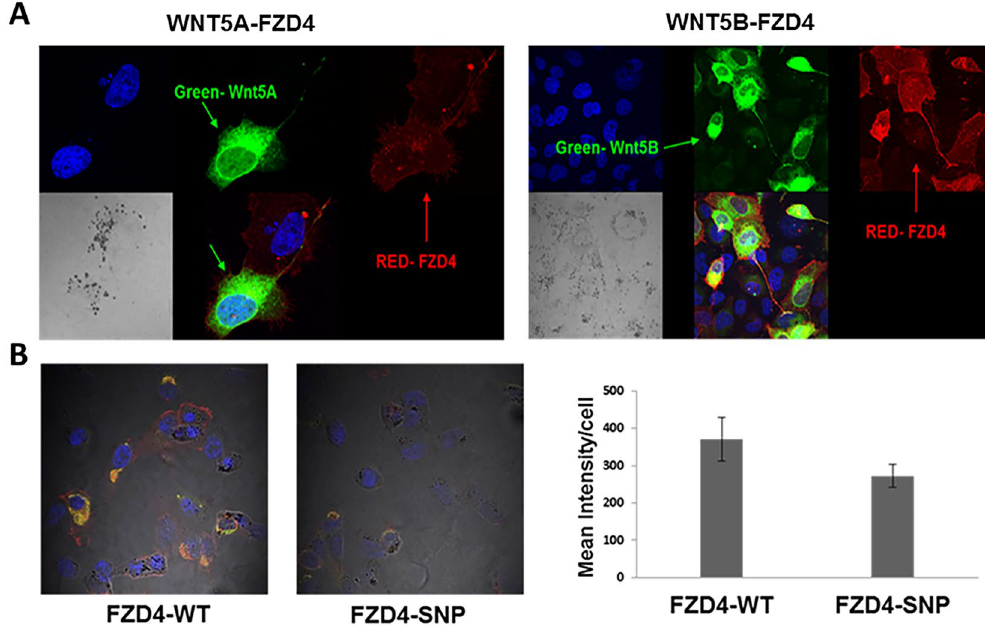
Figure 5. Modulation of FZD4 expression by WNT and FZD4 protein interaction in rs713065 variants in H1299 cells. (A) Interaction of Wnt ligands and FZD4 receptor in H1299 cells transfected with Wnt-5A-V5 and FZD4-FLAG expression plasmids shown by confocal fluorescence imaging. (B) rs713065 (C) down-regulates FZD4, as quantitatively measured by confocal